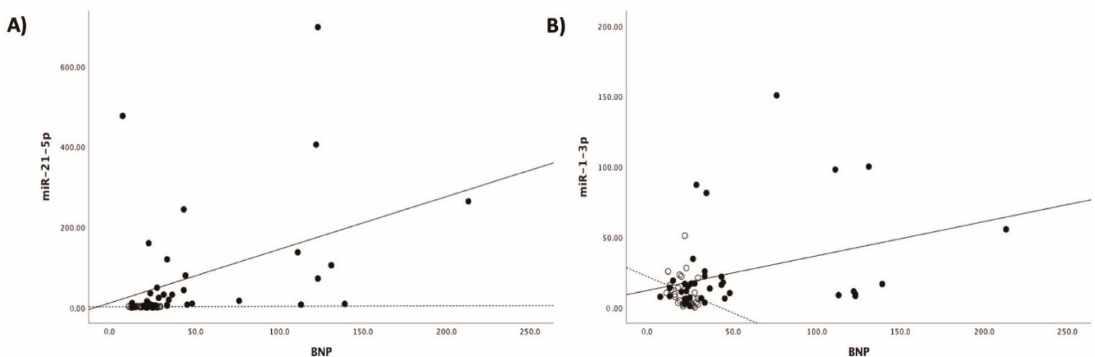
Figure 4. Correlation between ( A ) brain natriuretic peptide levels (BNP) and microRNA-1-3p (miR-1-3p) ( r = 0.35, p = 0.03) and ( B ) brain natriuretic peptide levels (BNP) and microRNA-21-5p (miR-21-5p) ( r = 0.41, p = 0.008) expression levels (arbitrary units calculated by the (2 − ddCt ) method) in patients with acute